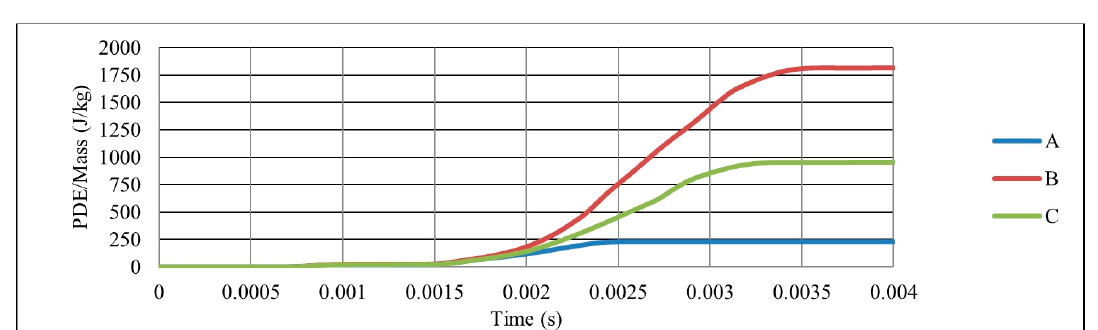
Figure 8. Ratio of PDE/Mass with respect to time, for three different cell dimensions A, B and C with θ = 60 ◦ , t / L = 0.2, subjected to the same loading conditions.